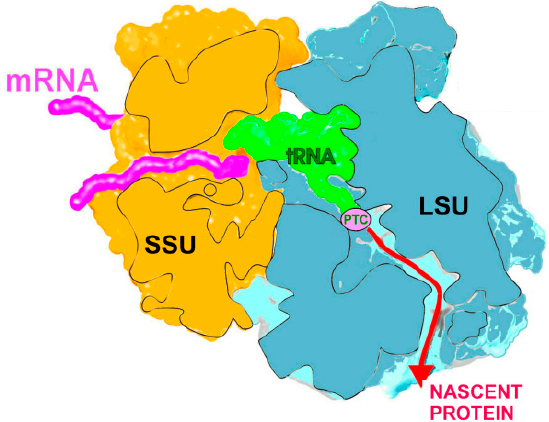
Figure 1. Overall structure of the bacterial ribosome showing the two subunits: the small (SSU) and the large (LSU), the mRNA, the PTC, and the nascent protein exit tunnel.